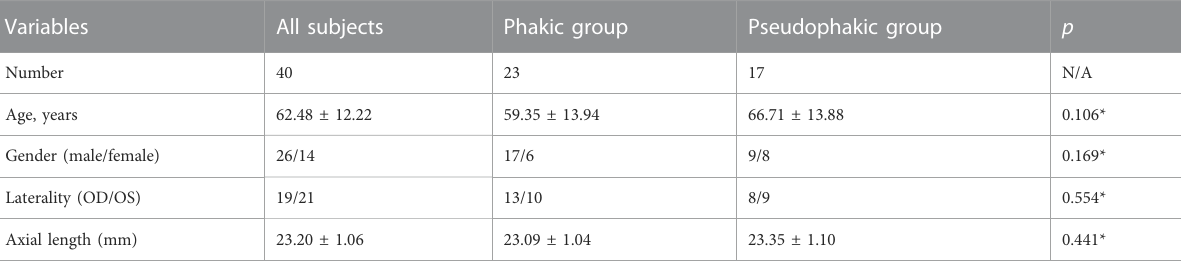
TABLE 1 Clinical characteristics and demographics of the